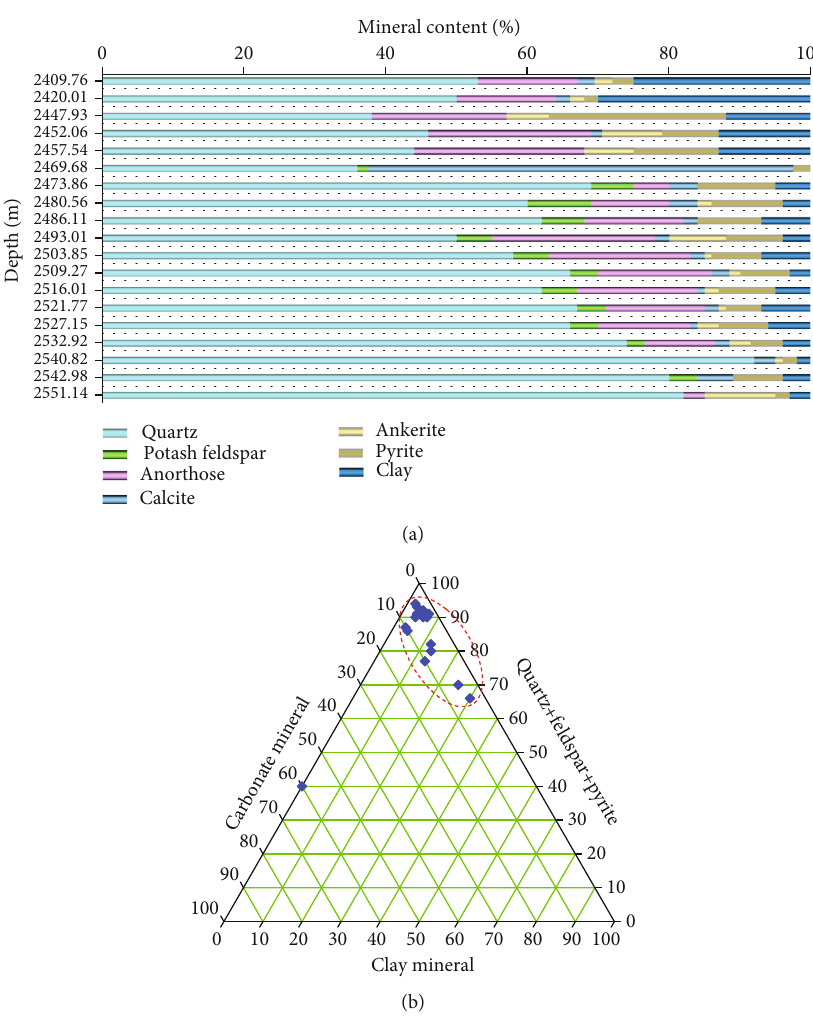
Figure 3: Proportional distribution of mineral content: (a, b) the mineral compositions and proportions of the 20 samples, respectively.